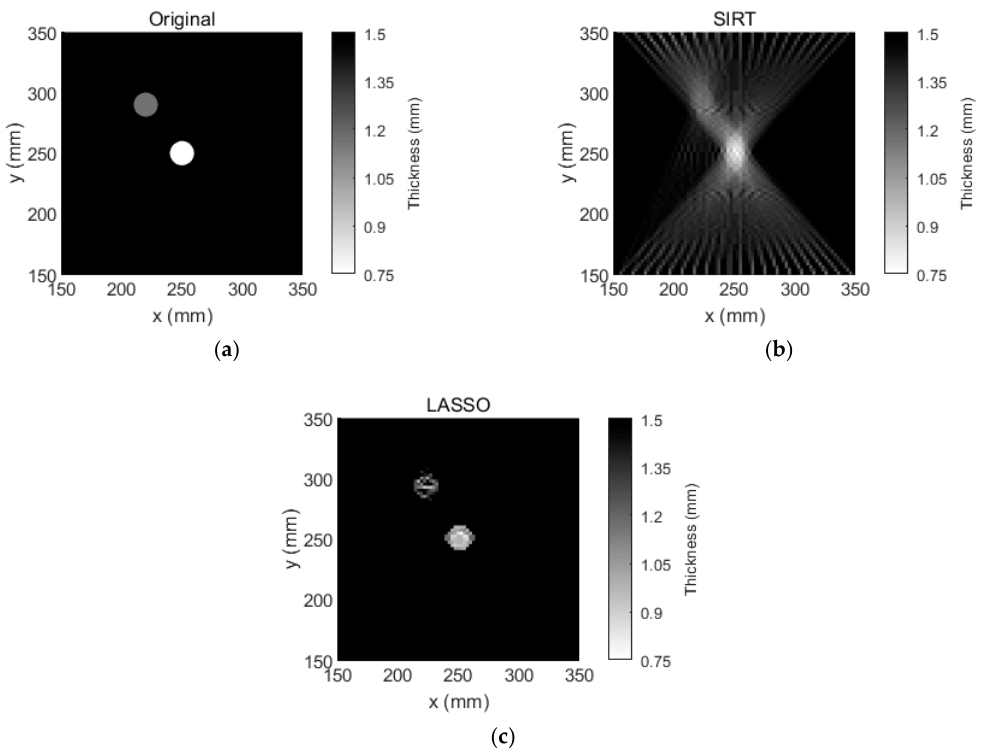
Figure 8. Tomographic reconstruction images for a 1.5 mm thick aluminum plate with two 20 mm diameter circular flat-bottomed holes. Their thickness losses were respectively of 50% and 30% within the flaws. ( a ) The actual locations and sizes of the flaws. ( b ) The tomographic reconstruction image using the SIRT. ( c ) The tomographic reconstruction image using our method.